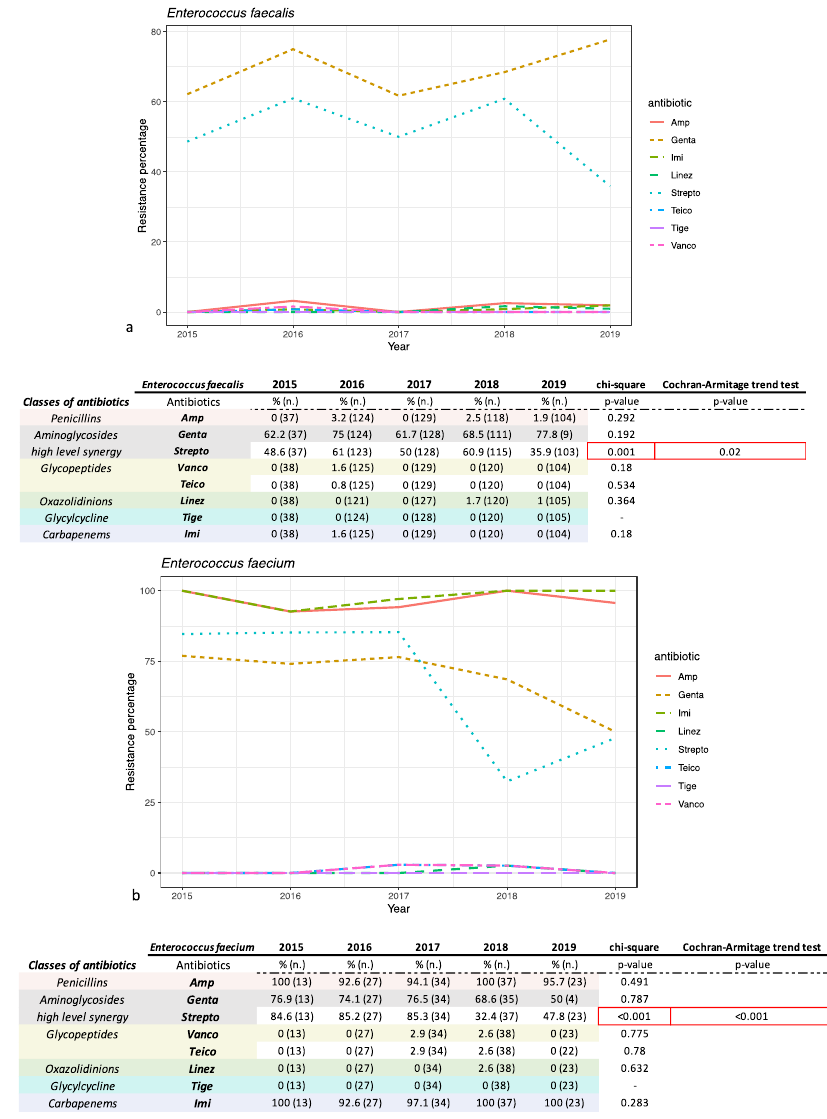
Figure 4. (a) E. faecium and (b) E. faecalis antimicrobial susceptibility trend percentage is reported for each year investigated in the study. The table under the image reports the relative resistance percentage analyzed in the chart, divided by classes of antibiotics tested. % = % of resistance for each year; n .= number of total assays conducted for each year. Abbreviations: Amp = ampicillin; Genta = Gentamicin; Strepto = streptomycin; Vanco = Vancomycin; Teico = teicoplanin; Linez = Linezoli; Tige = Tigecycline; Imi = Imipenem.